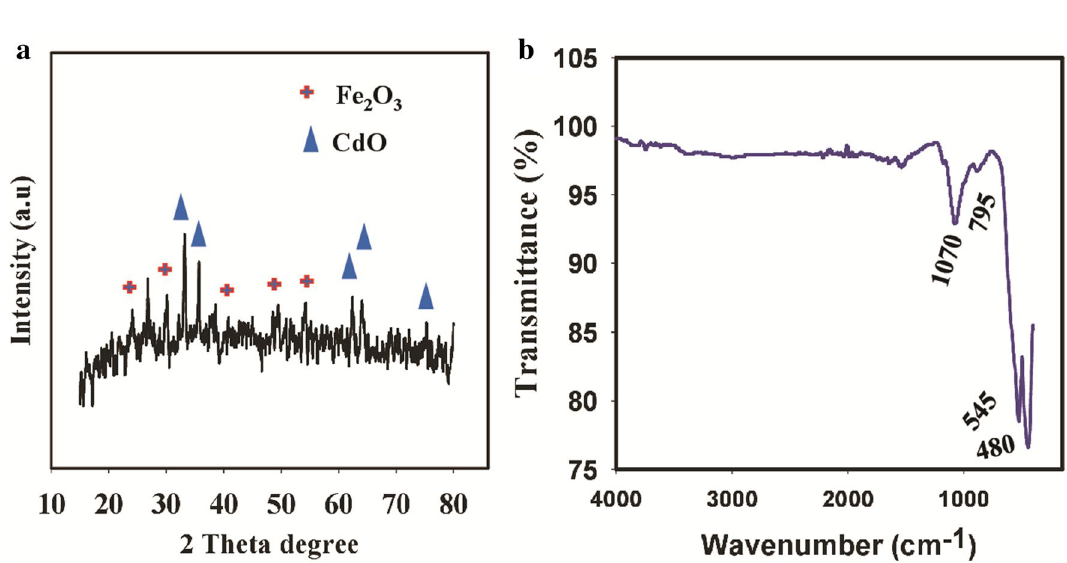
Figure 2. ( a ) XRD spectrum of CdFe 2 O 4 . ( b ) The obtained FTIR spectrum of CdFe 2 O 4